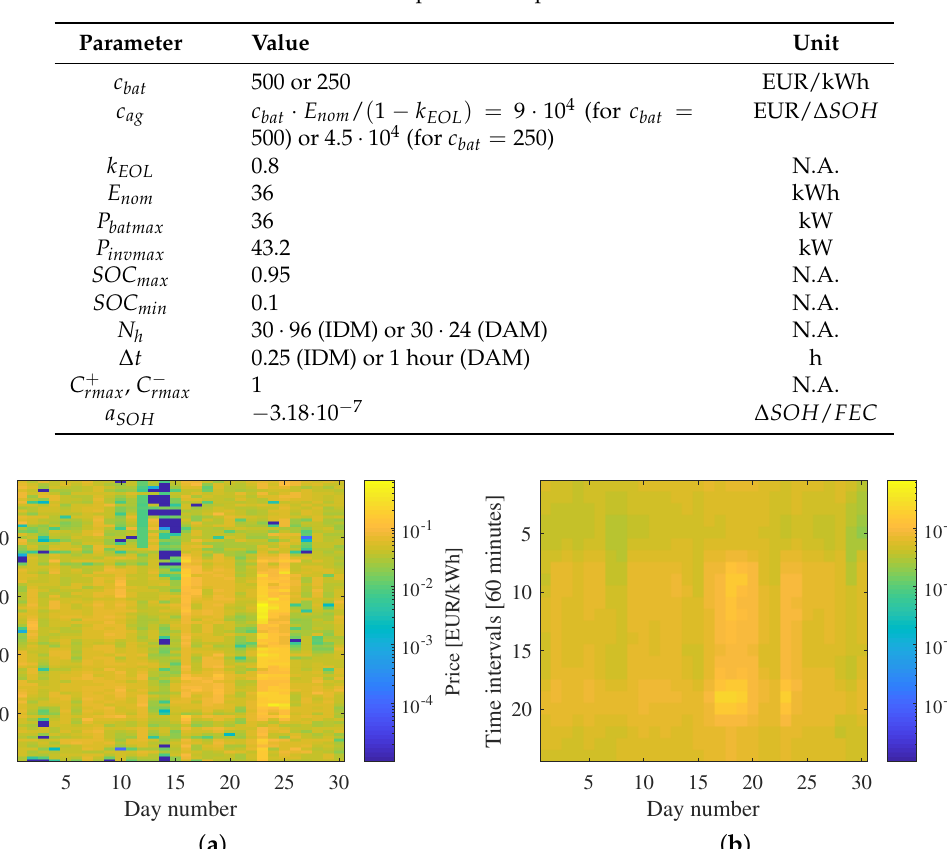
Table A2. Optimisation parameters.